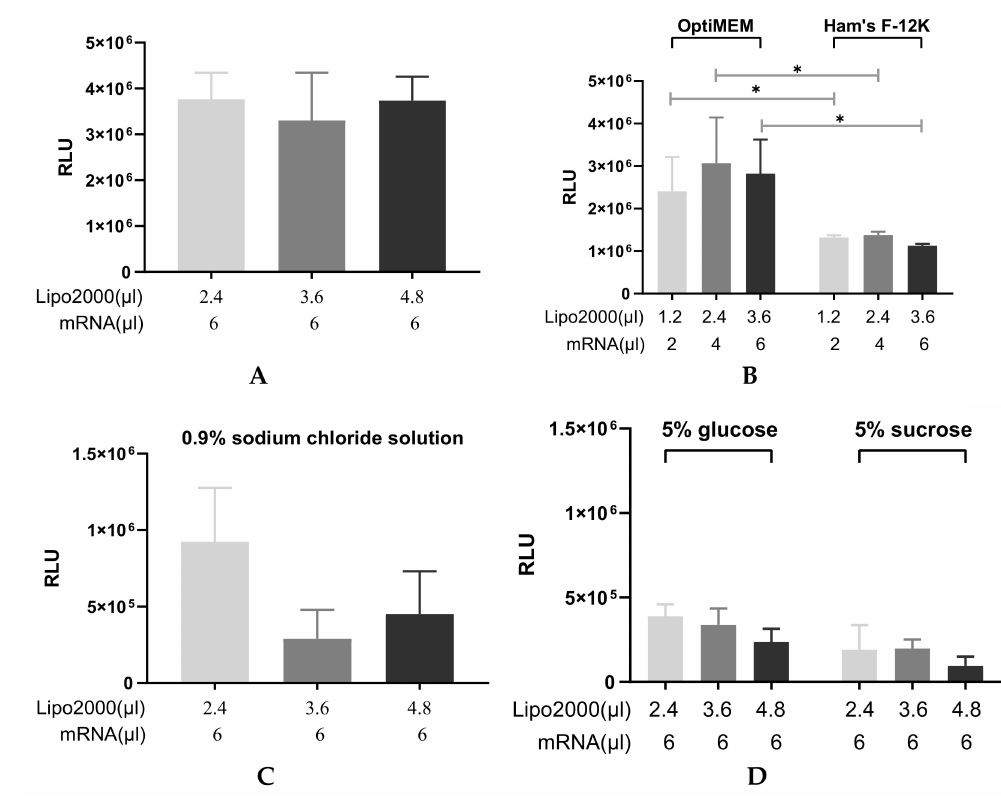
Figure 1. Optimization and characterization of the transfection process mediated by different IVT-mRNA/Lipofectamine2000 complexes. ( A ) Transfection efficiency of complexes prepared at different Lipofectamine2000-to-IVT-mRNA ratios in OptiMEM. Totals of 2.4 µ L, 3.6 µ L or 4.8 µ L Lipofectamine2000 were mixed with 6 µ L IVT-mRNA-encoding Metridia luciferase (0.1 µ g/ µ L), n = 4. ( B ) Transfection efficiency of complexes prepared in OptiMEM or Ham’s F-12K